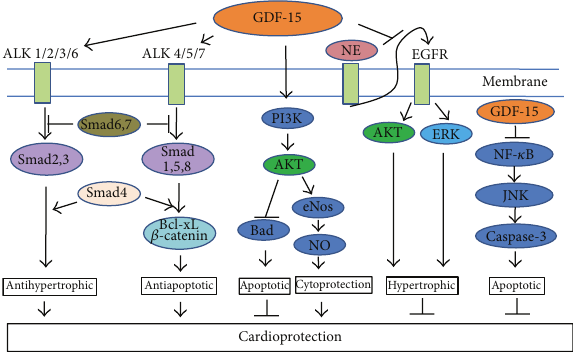
Figure 2: GDF-15 regulates signaling pathways essential for car- dioprotection. GDF-15 shows cardioprotective effect through acti- vation of ALK type 1 receptors (ALK 1 – 7) and phosphorylation of Smad2/3 and Smad1/5/8. After phosphorylation, Smad translocates to the nucleus in the form of heteromeric complex with Smad 4 and activates antihypertrophic pathway. GDF-15 also activates PI3K/AKT/eNOS/NO pathway and shows cardioprotection. GDF- 15 inhibits epidermal growth factor receptor (EGFR) transactivation and NF- 𝜅 B/JNK/caspase-3 pathway to show its cardioprotective